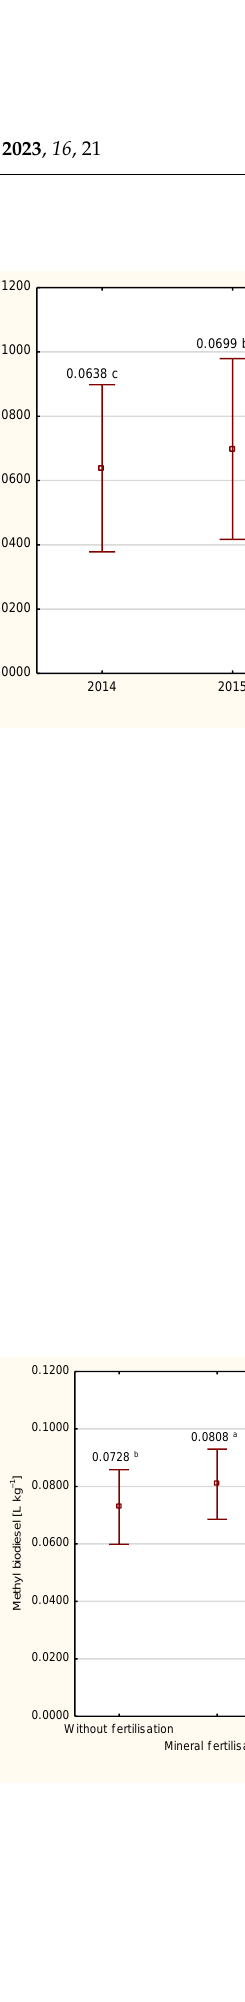
Figure 12. Volume of methyl biodiesel (mean value and standard deviation) obtained from corn grain ( a ) and bioethanol yield from a hectare ( b ), considering fertilization treatment. MBM — Meat and Bone Meal. a,b,c,d — Values followed by the same letters do not differ significantly in Tukey’s (HSD) test ( p < 0.05).